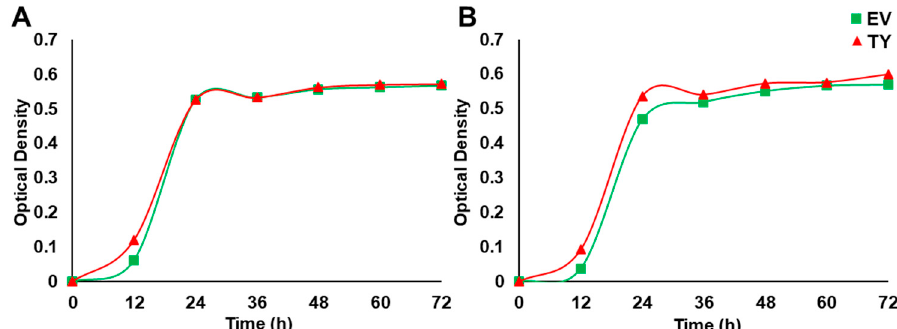
Figure 6. The effect of PdPIP1; 2 transgene on the growth of yeast cells in liquid culture. Yeast liquid culture assay used to test the relative tolerance of TY and EV cells grown under control ( A ) and 50 mM NaCl stress ( B ) conditions. The line represents the mean of the growth curves of yeast (± SE, n = 3).